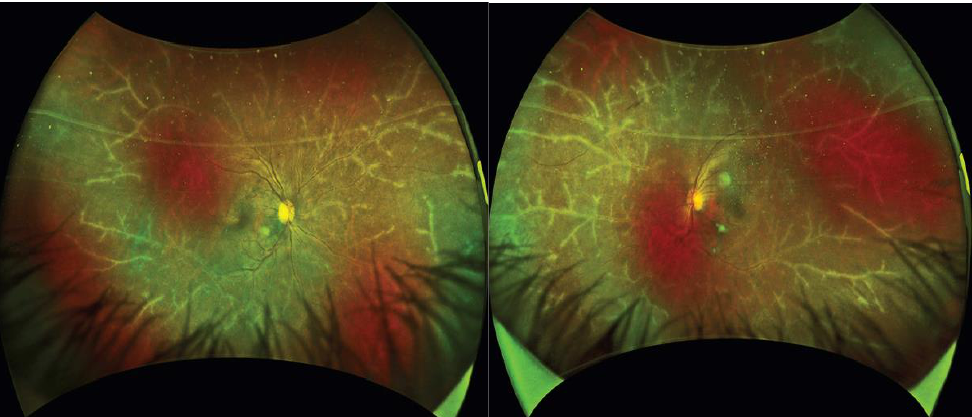
Figure 4. Frosted branch angiitis after allogenic hematopoietic stem-cell transplantation. (Reproduced with permission from Kamoi et al., Lancet Haematol. 2020 [75]).